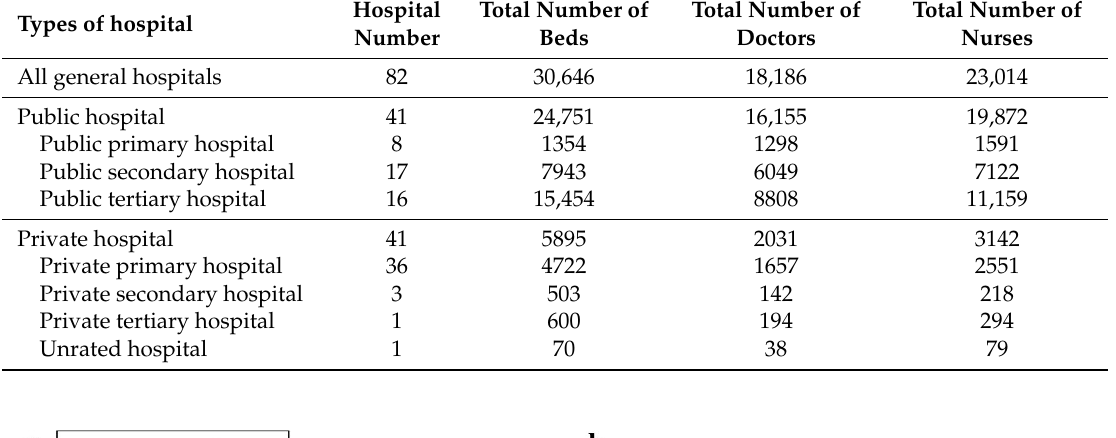
Table 1. Summary of general hospitals in Shenzhen, 2016.